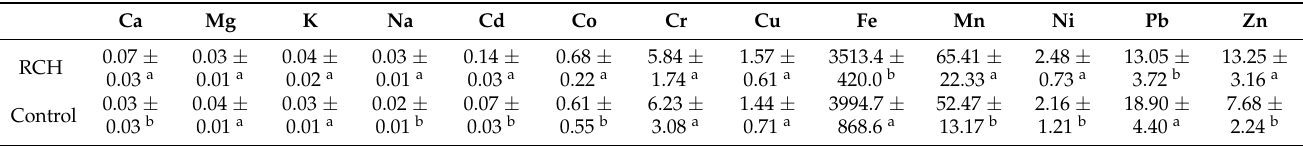
Figure 3. Difference in soil properties between charcoal hearth horizon (RCH) samples and control ( ∆ C–carbon content (%); ∆ P–phosphorus content (mg · kg − 1 ); ∆ BC–base cations content (cmol(+) · kg − 1 ); ∆ Mw–soil moisture in percent by weight (%); observations number of RCH). Table 4. Base cations content and microelements content in the charcoal hearth horizon (RCH) and control soil (experiment